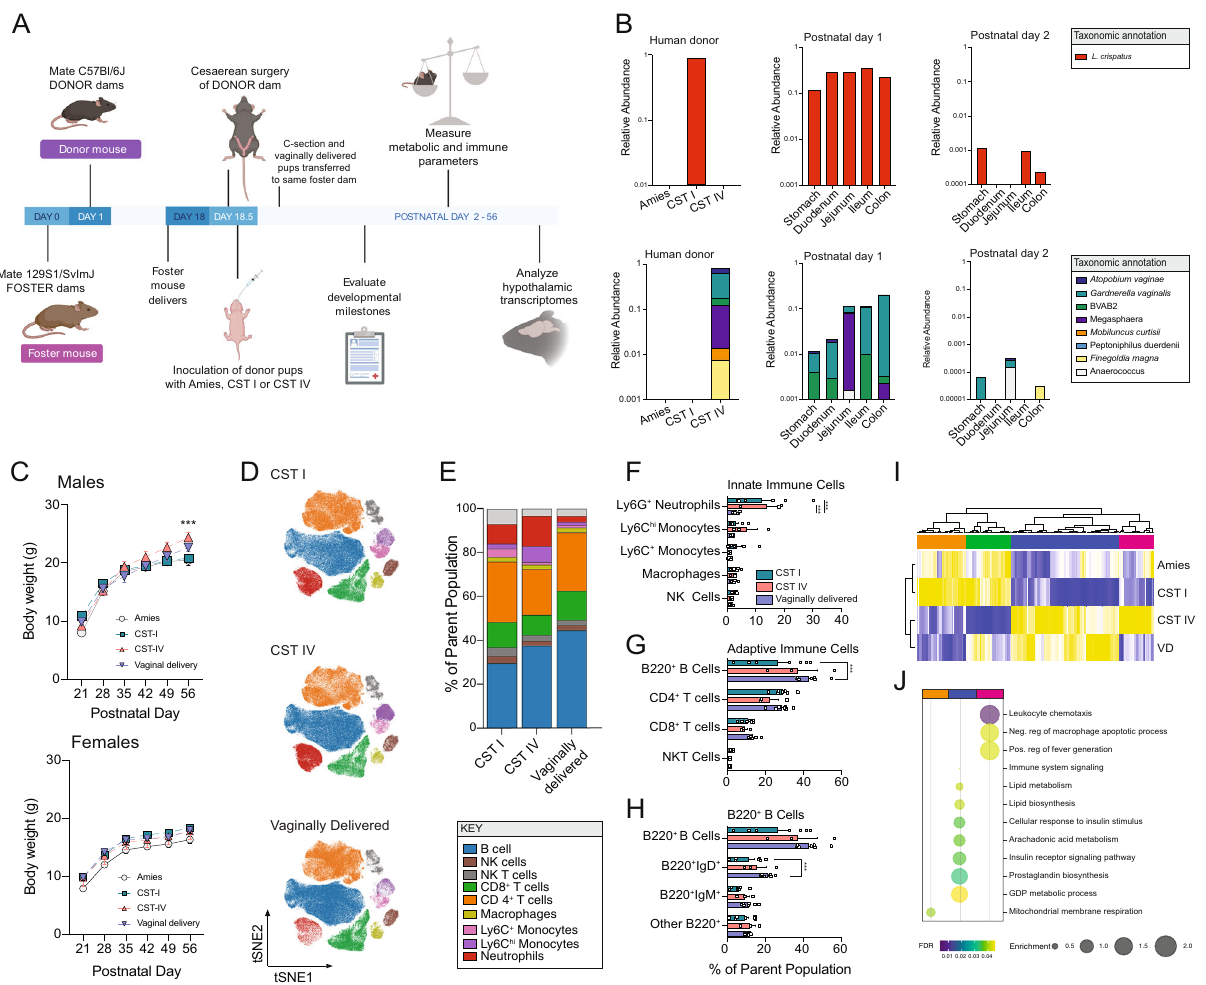
24 h post-inoculation revealed no ampli fi cation of CST IV taxa in pups inoculated with CST I, and CST IV inoculated offspring showed no ampli fi cation of CST I taxa (Fig. 1B). No ampli fi cation of CST I or CST IV taxa was observed in Amies inoculated